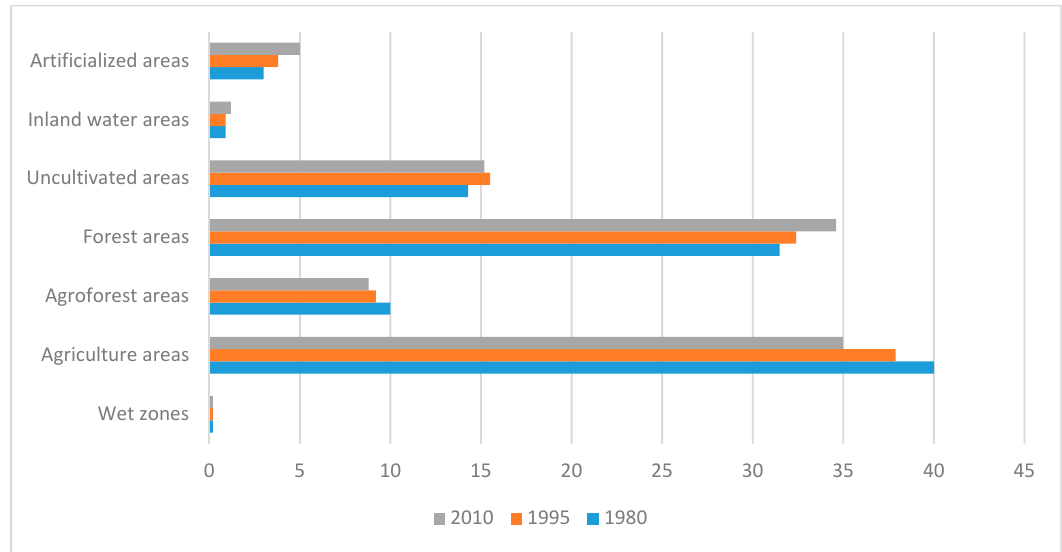
Figure 1. Areas of occupation for different land uses in Portugal (adapted from Reference [41]).